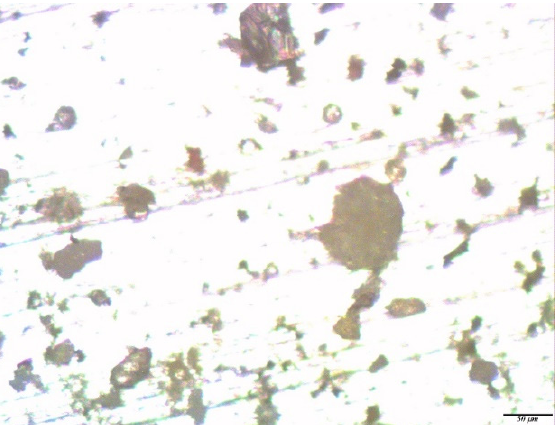
Figure 12. Micrograph of the surface area of an aluminum sample modified with a solution of a mixture of [1% VS + 1 mM BTA], after conducting full-scale, one-year natural tests in an urban atmosphere and removing the corrosion products.